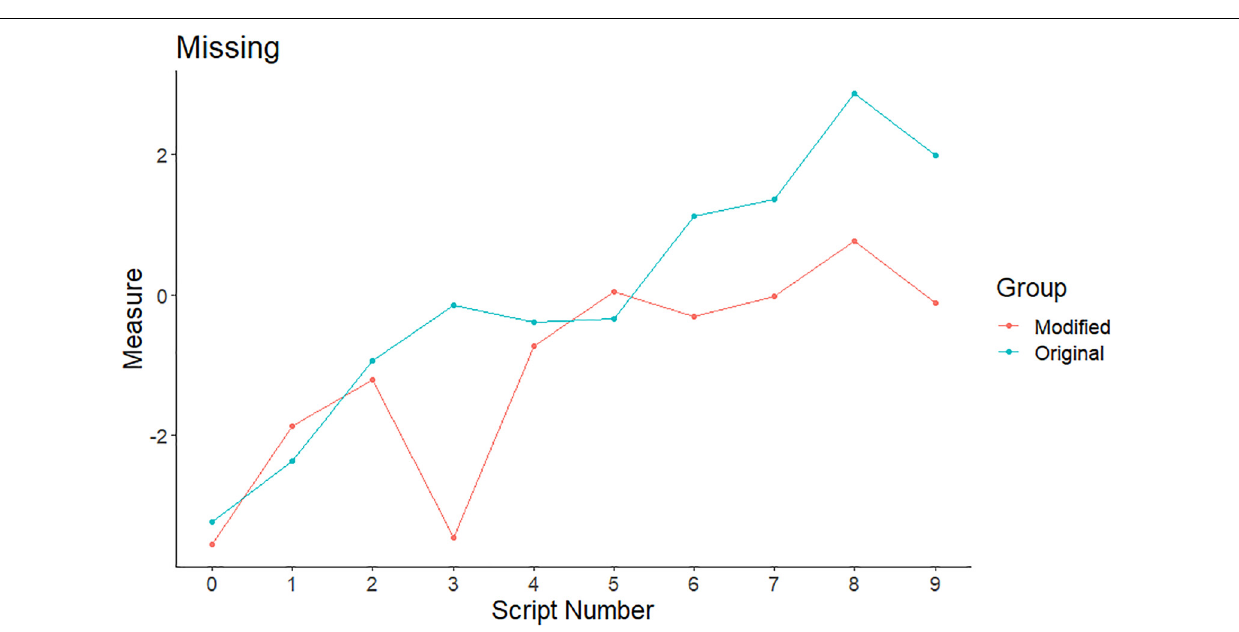
FIGURE 5 | CJ measures for the original and modified script variants: